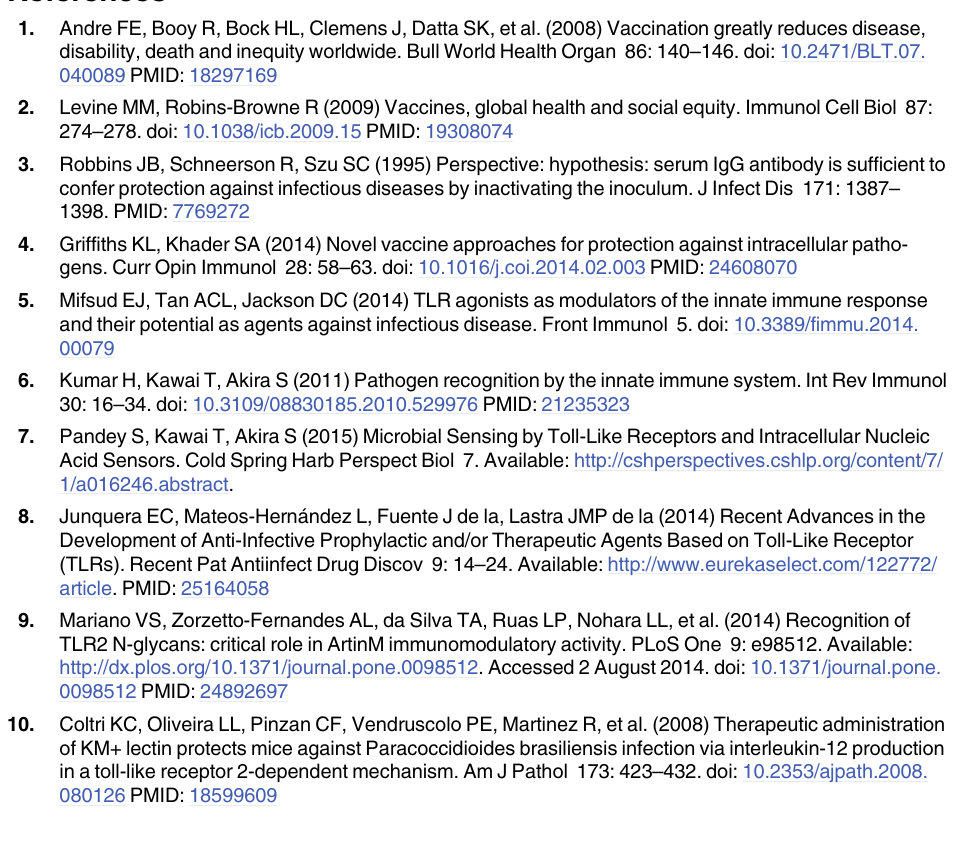
S5 Fig. AnnexinV Phycoerythrin labelling of a human neutrophils culture incubated with green-fluorescent forms of L . major promastigotes (MOI 3:1). Flow cytometry analysis showed that about 90% of cells were double labelled, regardless the ArtinM